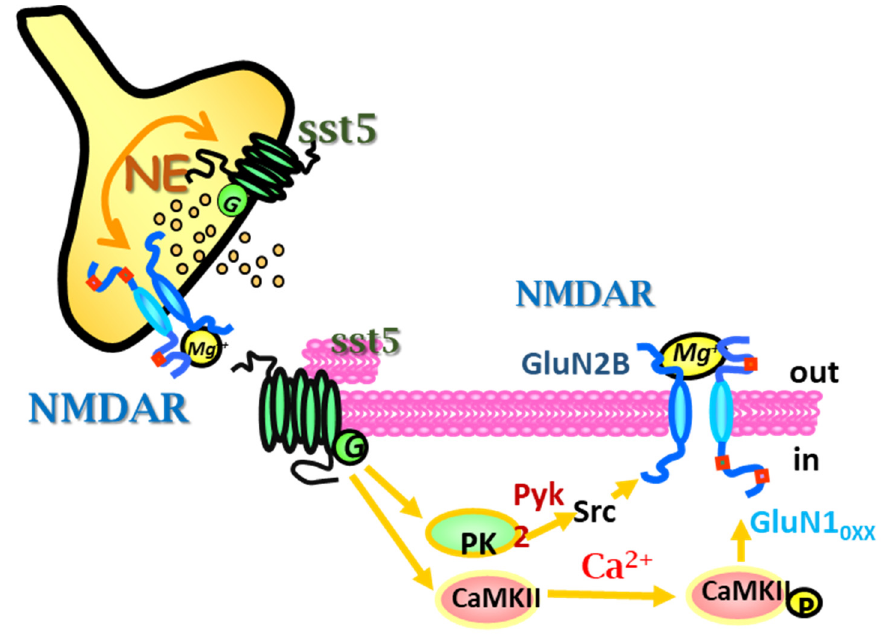
Figure 4. sst5 receptors activate and upregulate the colocalized and functionally coupled NMDA receptors in hippocampal isolated nerve terminals. A CaMKII-mediated pathway accounts for the sst5 receptor-mediated activation of NMDA re- ceptors in the presence of physiological Mg 2+ while a concomitant PLC/PKC/Src-mediated enzymatic pathway involving the proline-rich tyrosine kinase 2 (Pyk2) best accounts for the up-regulation of the NMDA receptor-mediated releasing